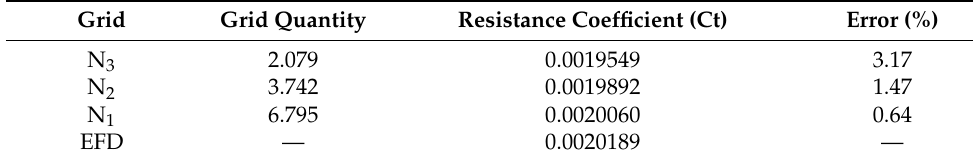
Table 5. Comparison of ship resistance in calm